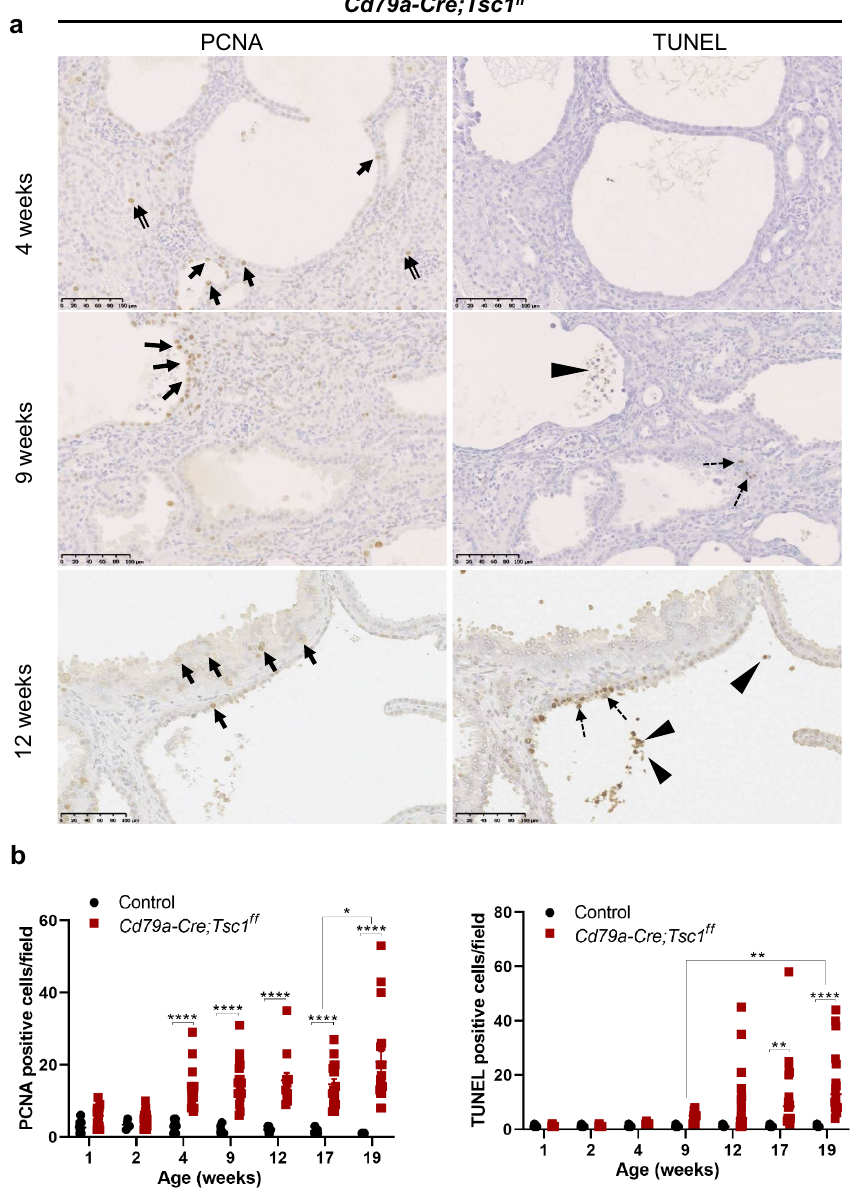
Figure 7. Proliferation and apoptosis in Cd79a-Tsc1 knockout (KO) kidneys. ( a ) Immunohistochemistry for proliferating cell nuclear antigen (PCNA) and terminal deoxynucleotidyl transferase dUTP nick end labeling (TUNEL) assay. Cd79a-Tsc1 KO kidneys were stained across developmental timepoints from postnatal week 1 to 19. In Cd79a-Tsc1 KO tubules at 4 weeks of age, PCNA-positive cells occasionally existed in both the cyst-lining (arrows) and non-cystic tubules (double arrows), while apoptosis was rarely observed. At 9 weeks, the number of PCNA-positive cells increased in the cyst-lining epithelia. In concordance with the increasing proliferation, apoptosis was more frequently observed in the cyst lining and interstitium. At later stages (12 weeks), apoptosis was seen focally in the cyst walls comprising multilayered, actively proliferating epithelial cells (dashed arrows) as well as in the cell debris that was exfoliated into the lumen (arrowheads). ( b ) Quantitative analysis. The frequencies of PCNA- and TUNEL-positive cells in tubules were greater in Cd79a-Tsc1 KO kidneys than in age-matched controls. After postnatal day 14, the enhanced proliferation in Cd79a-Tsc1 KO tubules became clearly discernible from controls ( P < 0.0001). In parallel with the accelerated proliferation, apoptotic cells gradually increased with age and reached a significant difference compared to controls after 9 weeks. Data represent mean ± SEM and were statistically analyzed by two-way ANOVA. . * P < 0.05, ** P < 0.01, and **** P <